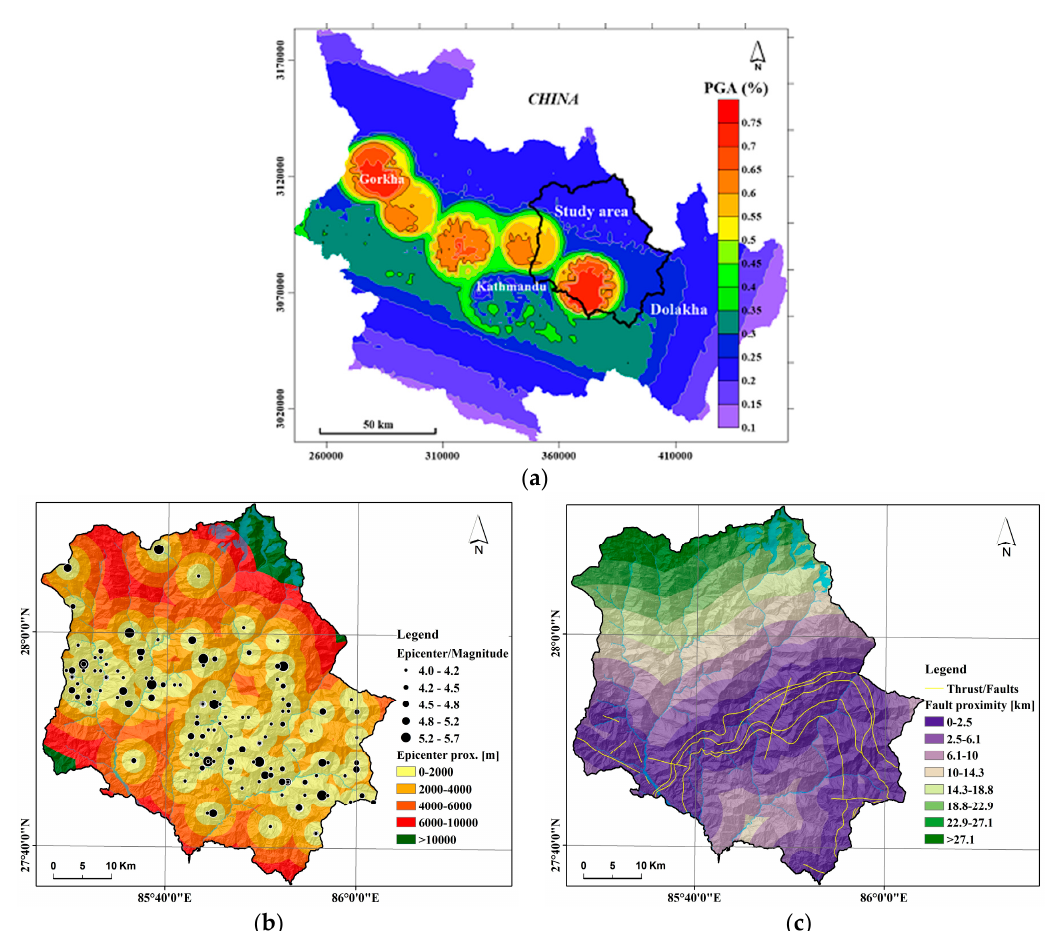
Figure 5. Seismic causative factors: ( a ) peak ground acceleration (PGA) map of earthquake-affected areas; ( b ) epicenter proximity; ( c ) fault proximity.